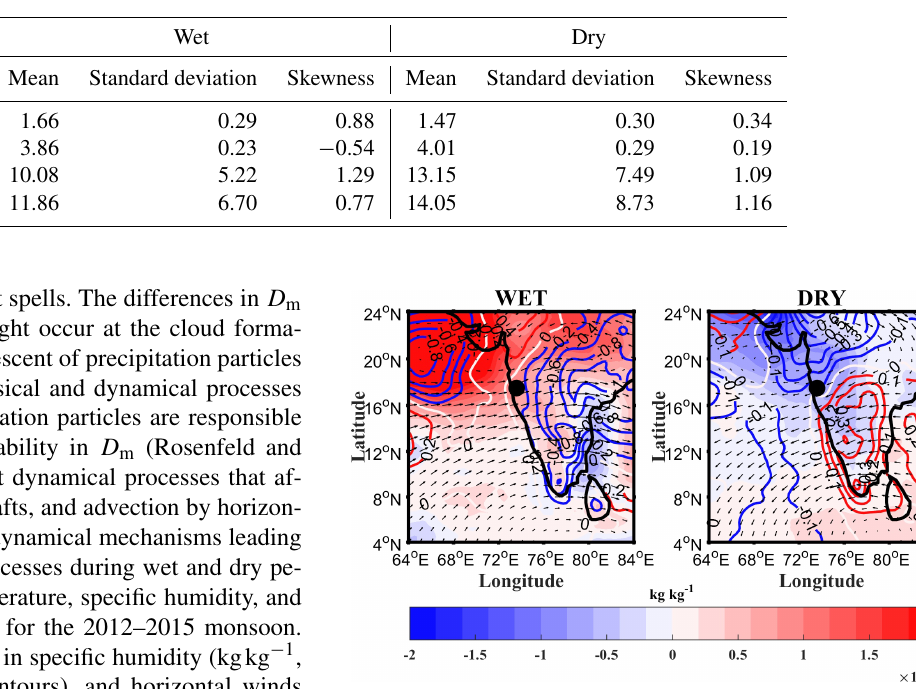
Figure 9. Spatial distribution of anomalies in specific humidity (kgkg − 1 , shading), temperature (K, contours), and horizontal winds (vectors) at 850hPa during wet and dry spells in the monsoon for 2012–2015. Here, positive anomalies in specific humidity (tempera- ture) represent an increase in moisture content (heating), and a nega- tive anomaly represents a decrease in moisture (cooling). The black dot represents the observational site.